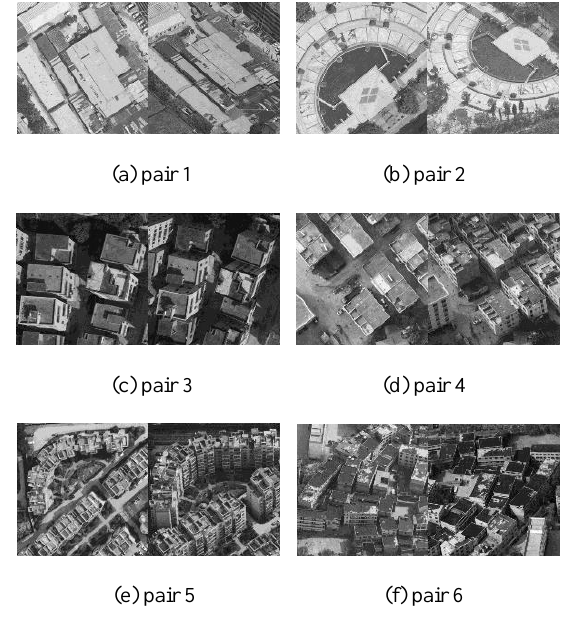
Figure 8. Experimental